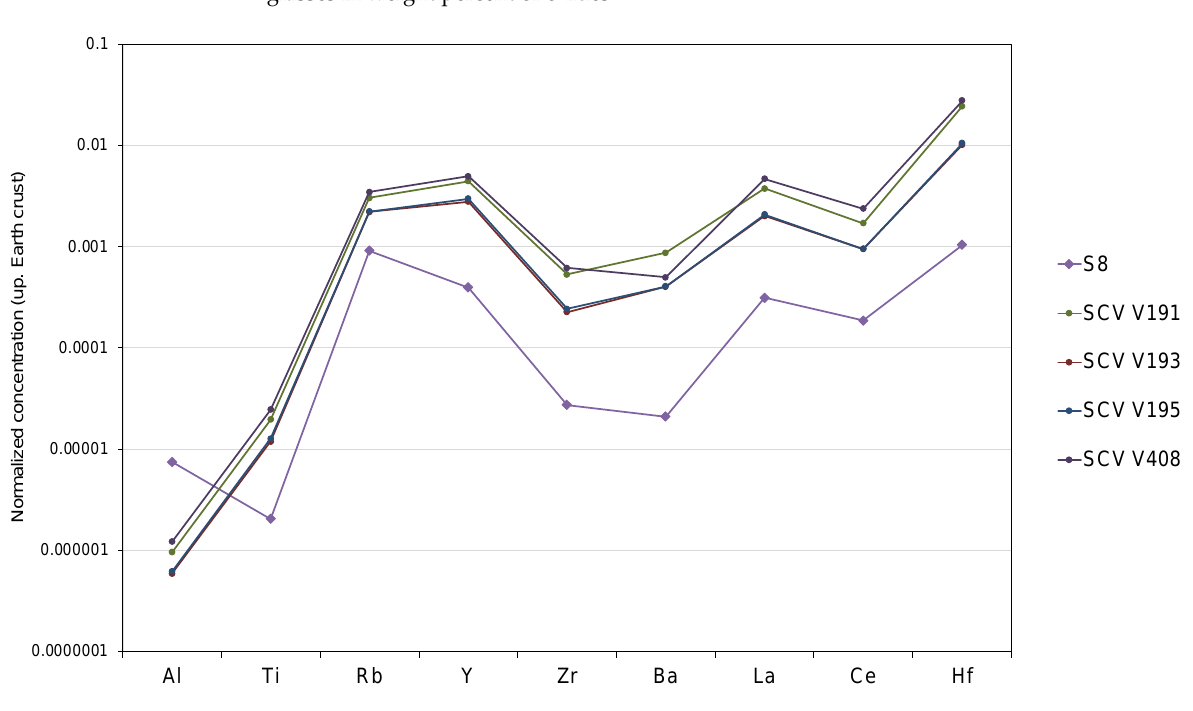
Figure 6. Contents of selected trace elements and rare earth elements normalised to the upper Earth crust [30] for S8 synthesised glass and for four SCV historical glasses identified as genuine Venetian imports in logarithmic scale.